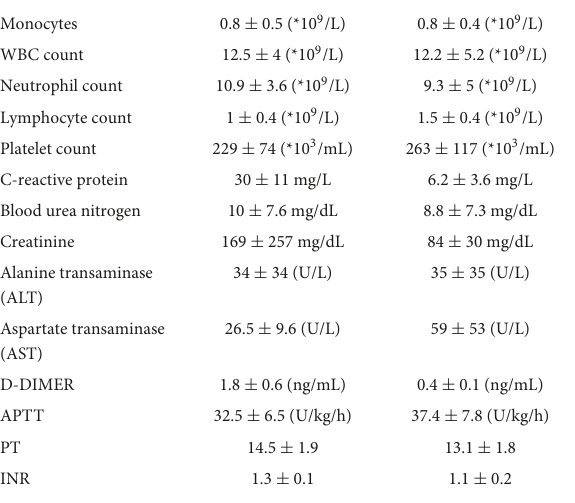
TABLE 2 Lab test values.